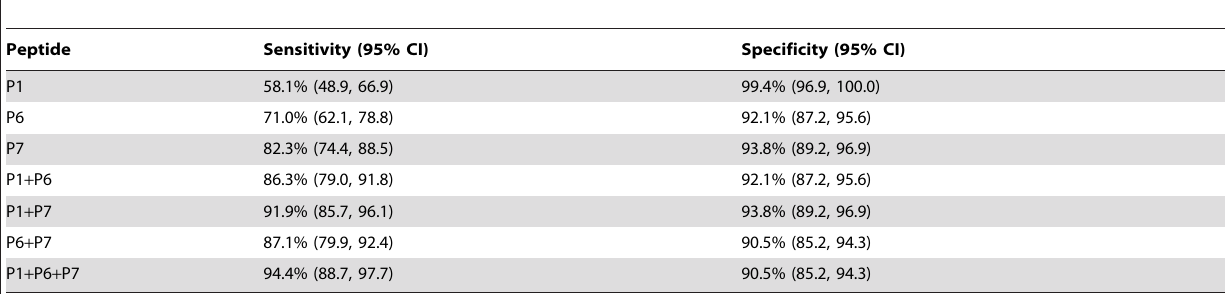
Table 2. Performance characteristics of peptides and peptide combinations for TB diagnosis.